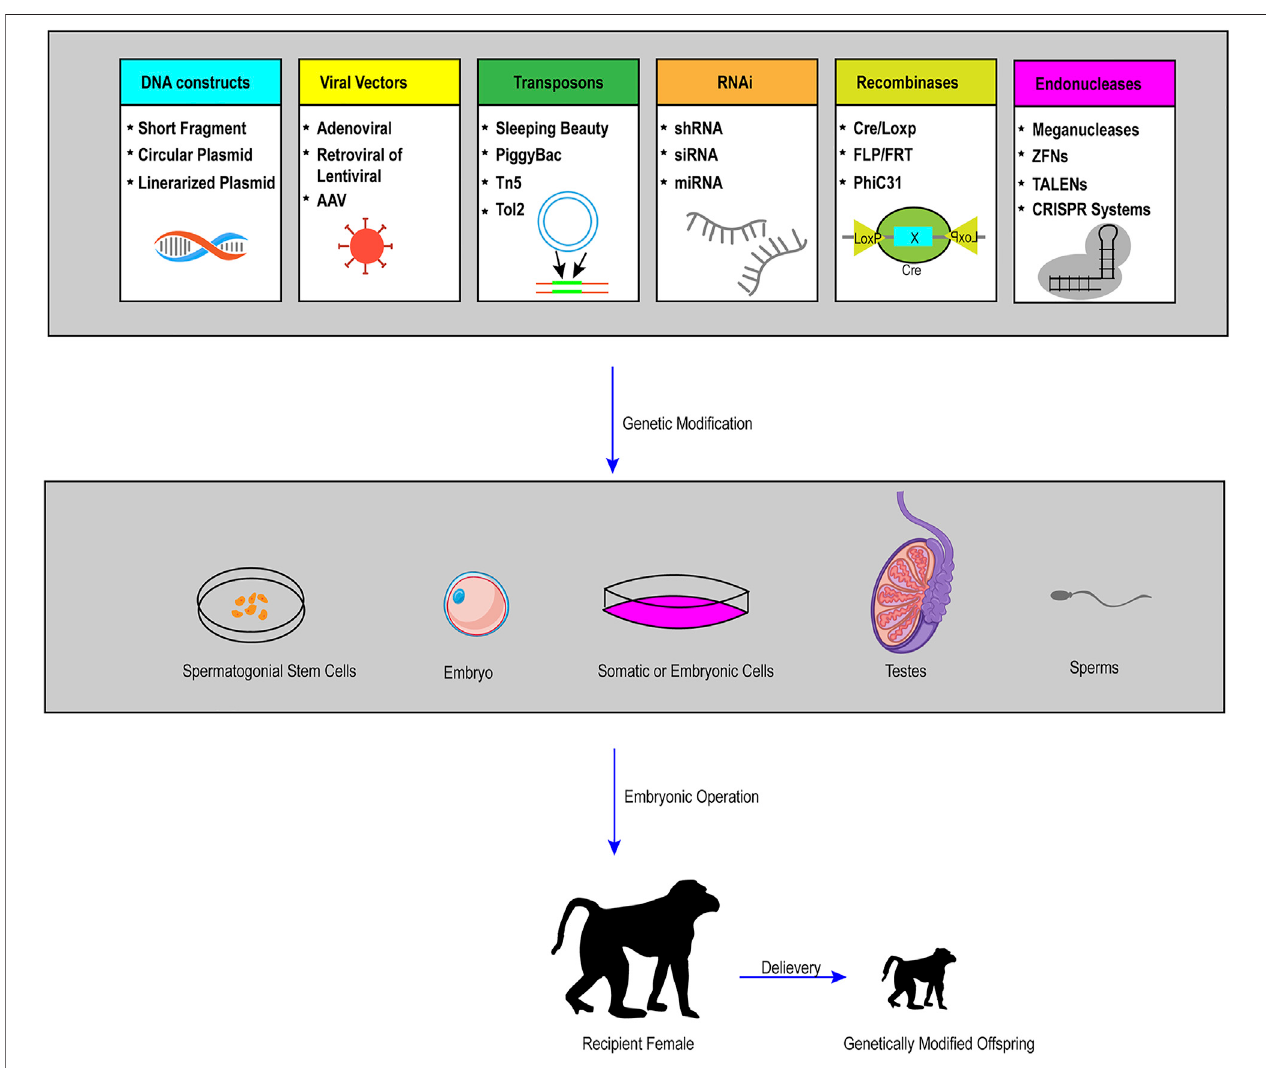
FIGURE 3 | Schematic representation of practical and possible pathways of genetic modi fi cation in large animals. To achieve the generation of live founders with desiredgeneticmodi fi cations(pronuclearinjectionandnucleartransferarethetwoprimaryprocedures),the fi rststepistoconductgenemanipulationsinavarietyofcells or organs, including somatic cells, embryonic cells, embryos, spermatozoa, SSCs and other targeted organs by the use of many tools, such as viral vectors, recombinases, transposons, RNA interference (RNAi), and endonucleases. Through a series of embryonic operations, such as nuclear transfer, genetically modi fi ed cells or embryos can produce genetically modi fi ed